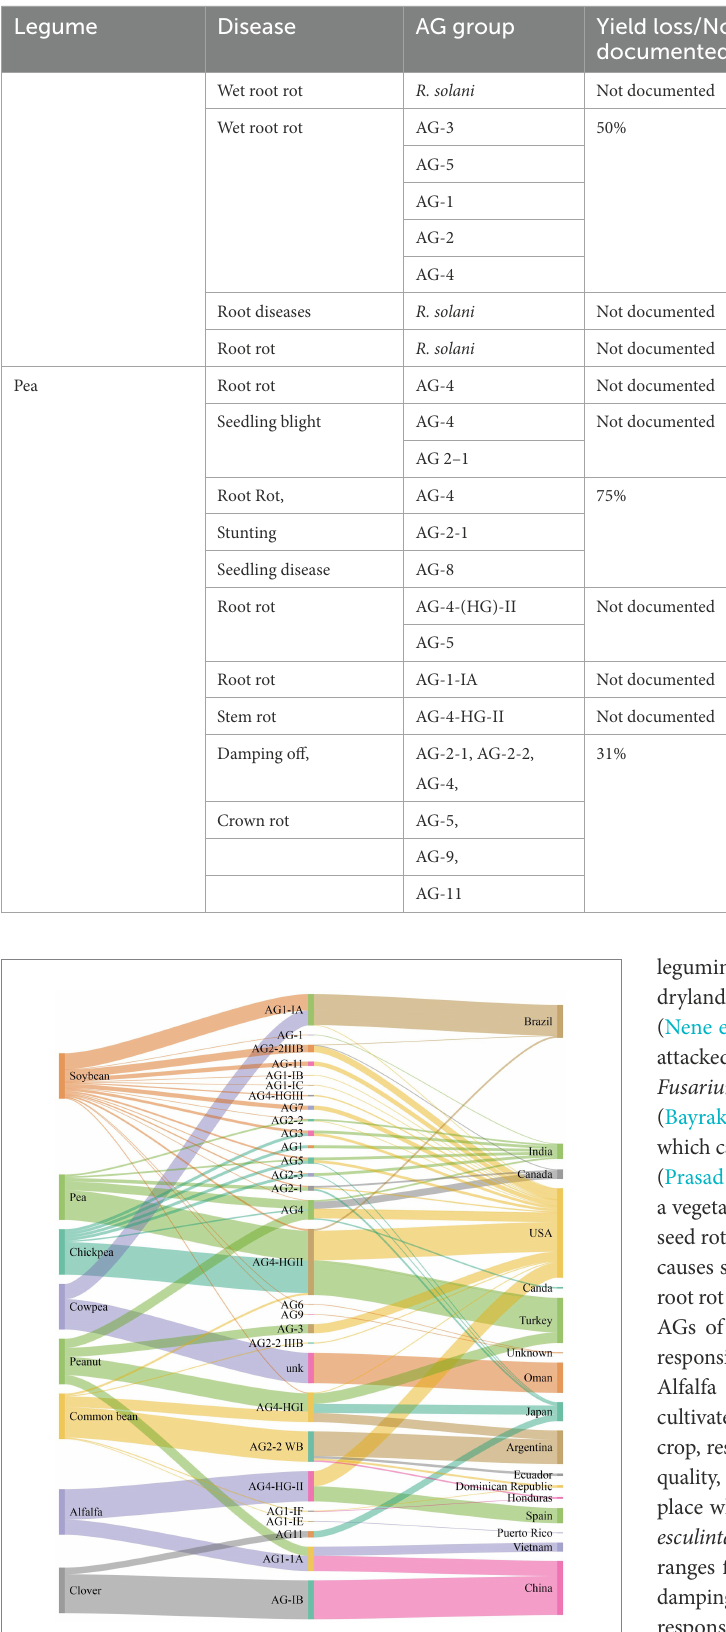
FIGURE 2 Number of anastomosis groups (AGs) and their subgroups of R. solani associated with legumes crops and geographical